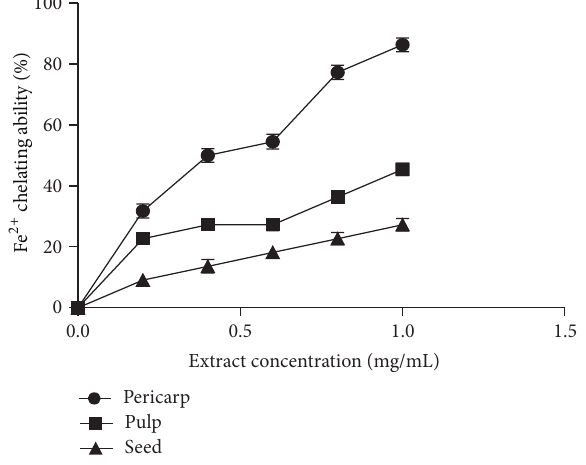
Figure 7: Fe 2+ chelating ability (%) of the aqueous extracts of the pericarp, pulp, and seed of Soursop